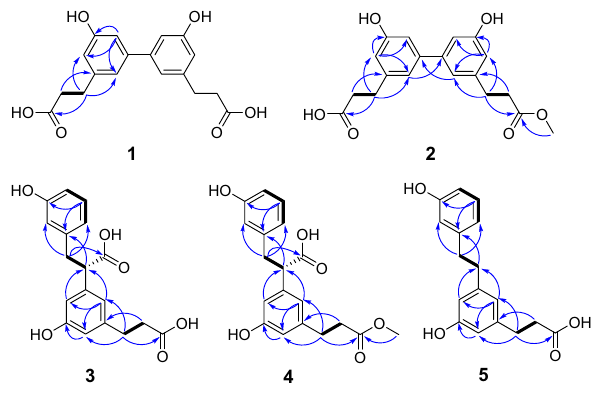
Fig. 2 1 H– 1 H COSY (black bond) and key HMBC (blue arrow)